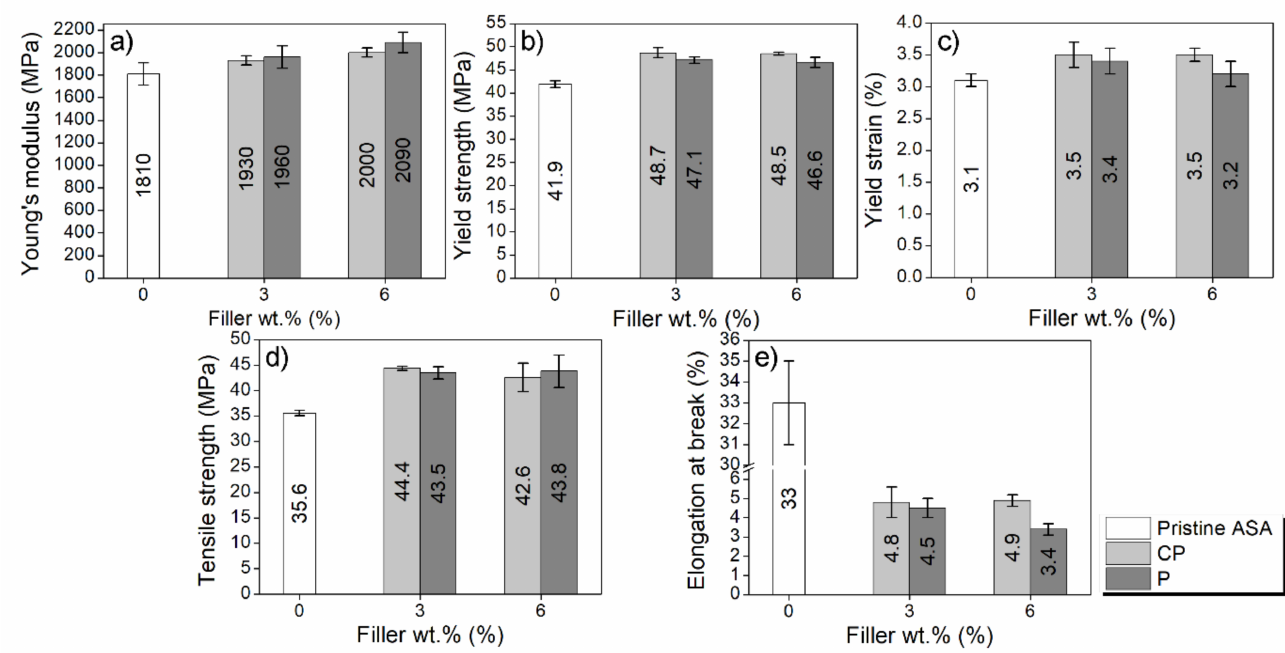
Figure 2. Mechanical properties of the injected pristine ASA (white bars), ASA-CP (light grey bars), and ASA-P (dark grey bars) with confidence intervals. ( a ) Young’s modulus; ( b ) yield strength; ( c ) yield strain; ( d ) Tensile strength, and ( e ) elongation at